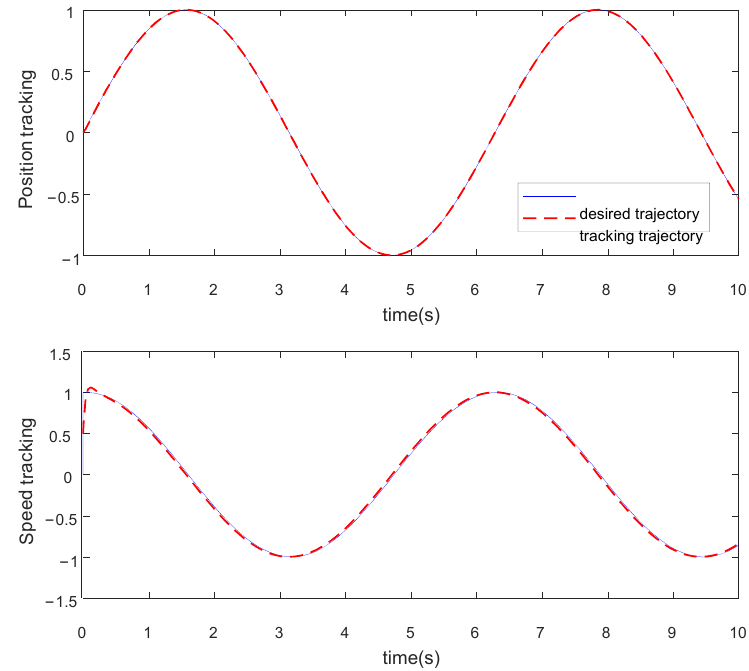
Figure 5. Position and velocity tracking curves with error compensation.